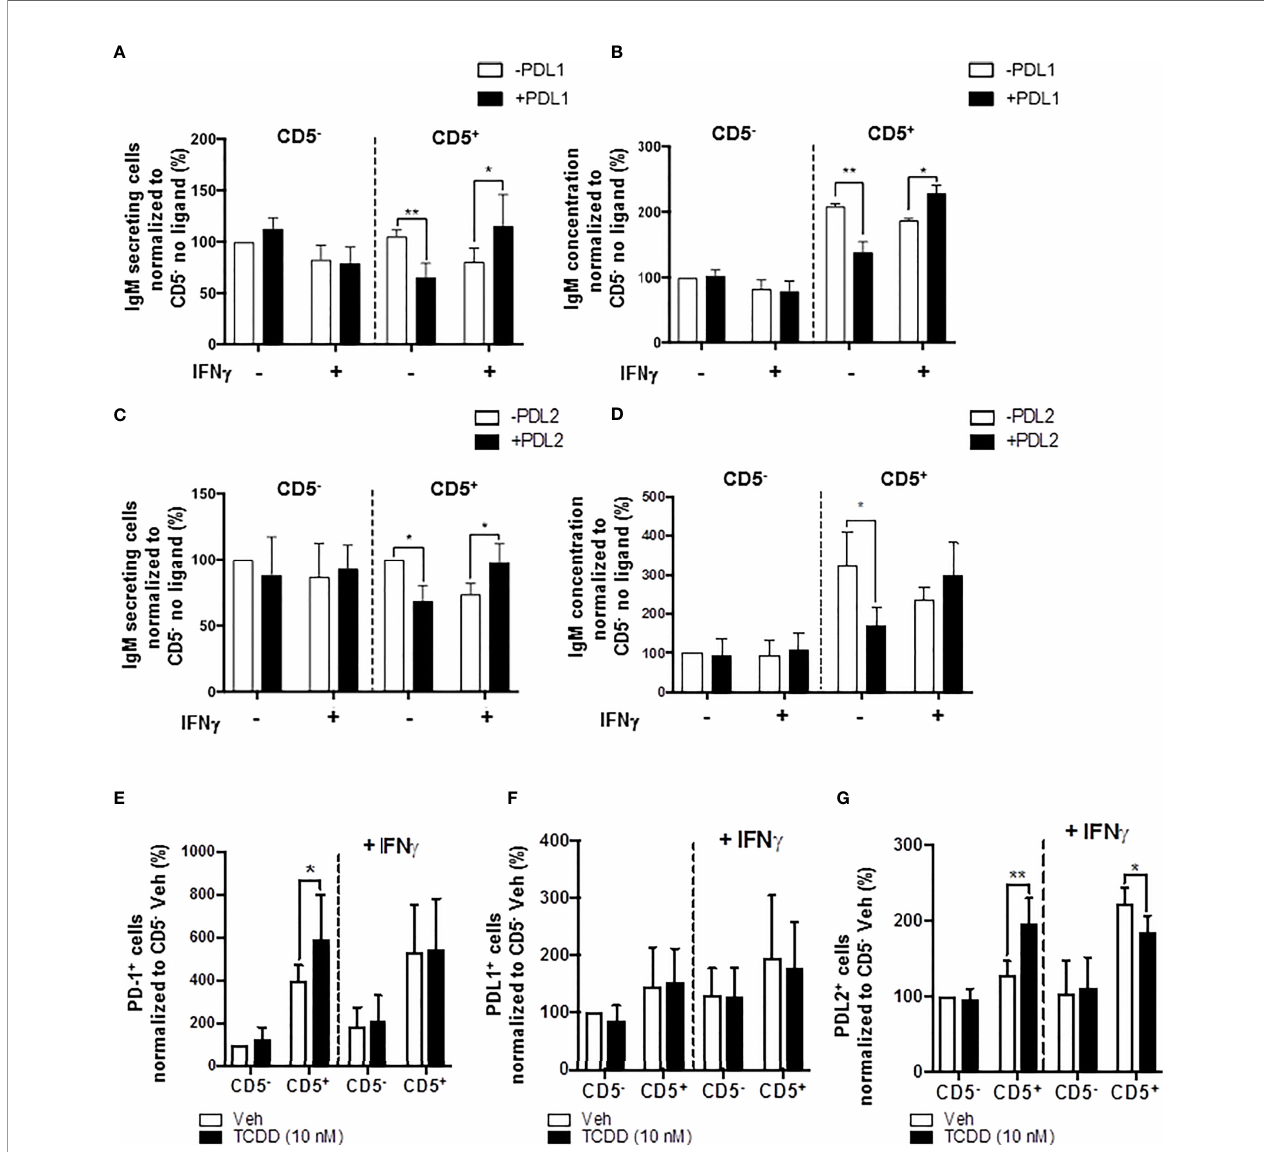
FIGURE 11 | IFN g treatment blocks PD-1-mediated IgM suppression in CD5 + ILBs. Human CD5 +/- B cells were activated, treated with soluble PDL1 or PDL2 on day 0 and cultured for 7 days as previously described. In addition, IFN g treatment (1 U/mL) was provided on day 0. (A) Average number of IgM secreting cells; (B) Average IgM concentration from culture supernatants treated with soluble PDL1 within CD5 +/- cultures in the presence of IFN g treatment; (C) Averaged number of IgM secreting cells; (D) Average IgM concentration from culture supernatants treated with soluble PDL1 within CD5 +/- cultures in the presence of IFN g treatment; (E) Average frequency of PD-1 + cells; (F) Average frequency of PDL1 + cells; and (G) Average frequency of PDL2 + in CD5 +/- populations with or without IFN g treatment. Determinations were made using B cells from 6 human donors (N = 6) across two independent experiments. For (A – D) , results were normalized to CD5 - B cells without soluble PD-1 ligand treatment. For (E – G) , results were normalized to the Veh control group in CD5 − B cells. Signi fi cant differences are indicated by * p < 0.05 and ** p < 0.01 (two-way ANOVA following with Fisher ’ s LSD post hoc